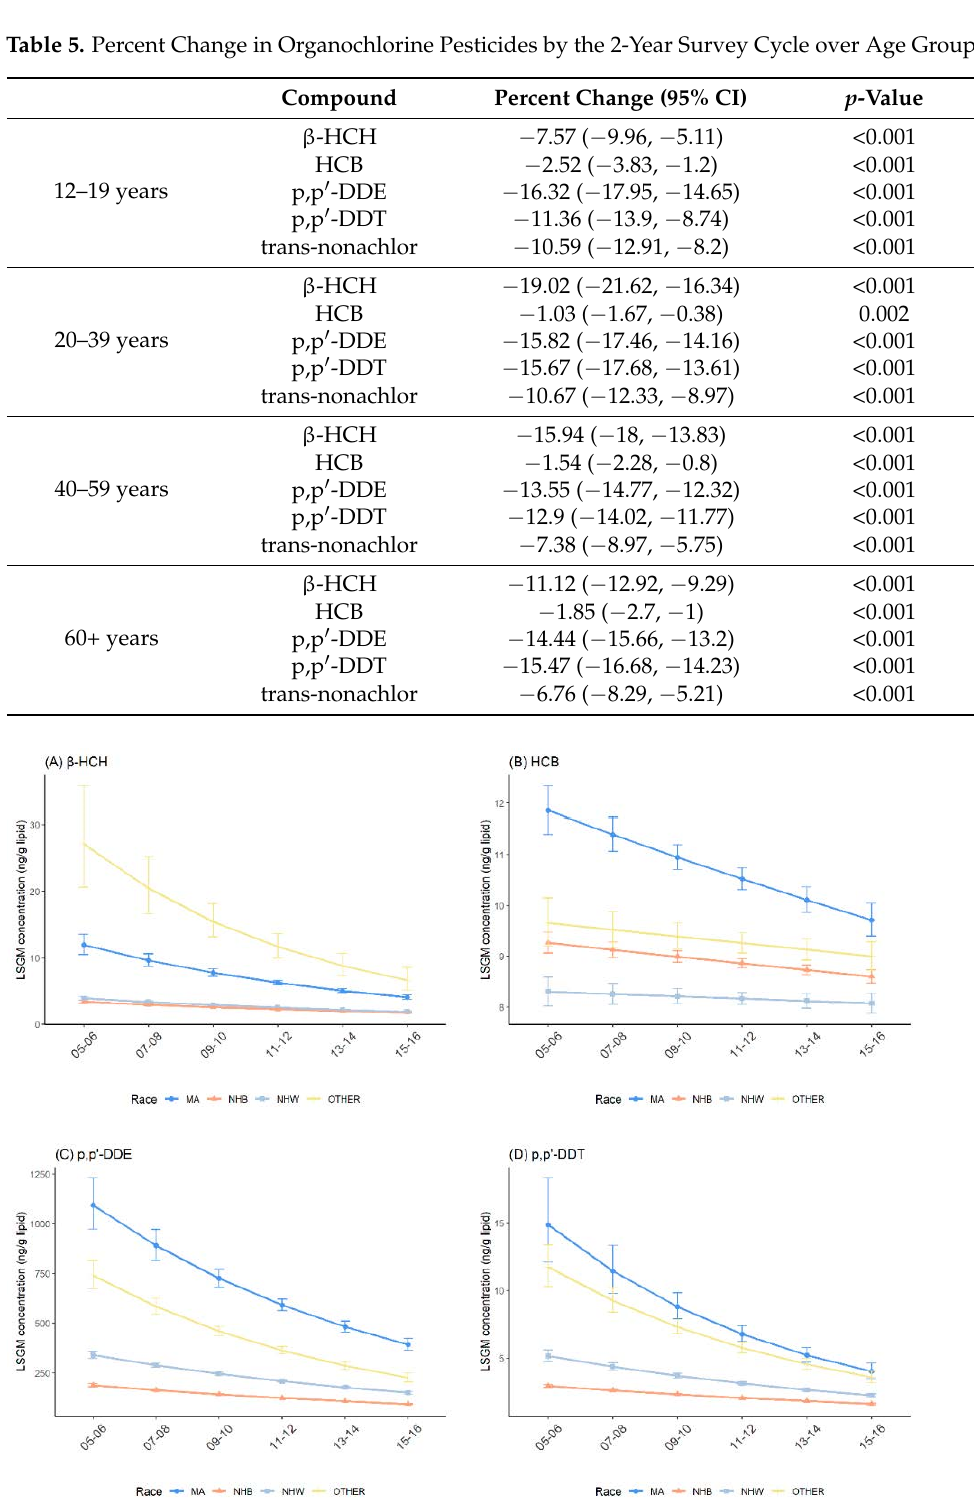
Figure 4. Temporal trends in serum OCP concentrations over survey cycles by race/ethnicity. Least square geometric mean (LSGM) and 95% confidence interval (95% CI) for each survey cycle esti- mated from linear regression models adjusted for sex and age group; interaction term is survey cycles##race/ethnicity. Data points represent LSGM, and error bars represent 95% CI. ( A ): β‐ HCH. ( B ): HCB. ( C ): p,p ′‐ DDE. ( D ): p,p ′‐ DDT. MA = Mexican American; NHB = Non ‐ Hispanic Black; NHW = Non ‐ Hispanic White; and OTHER = other than MA, NHB and NHW.